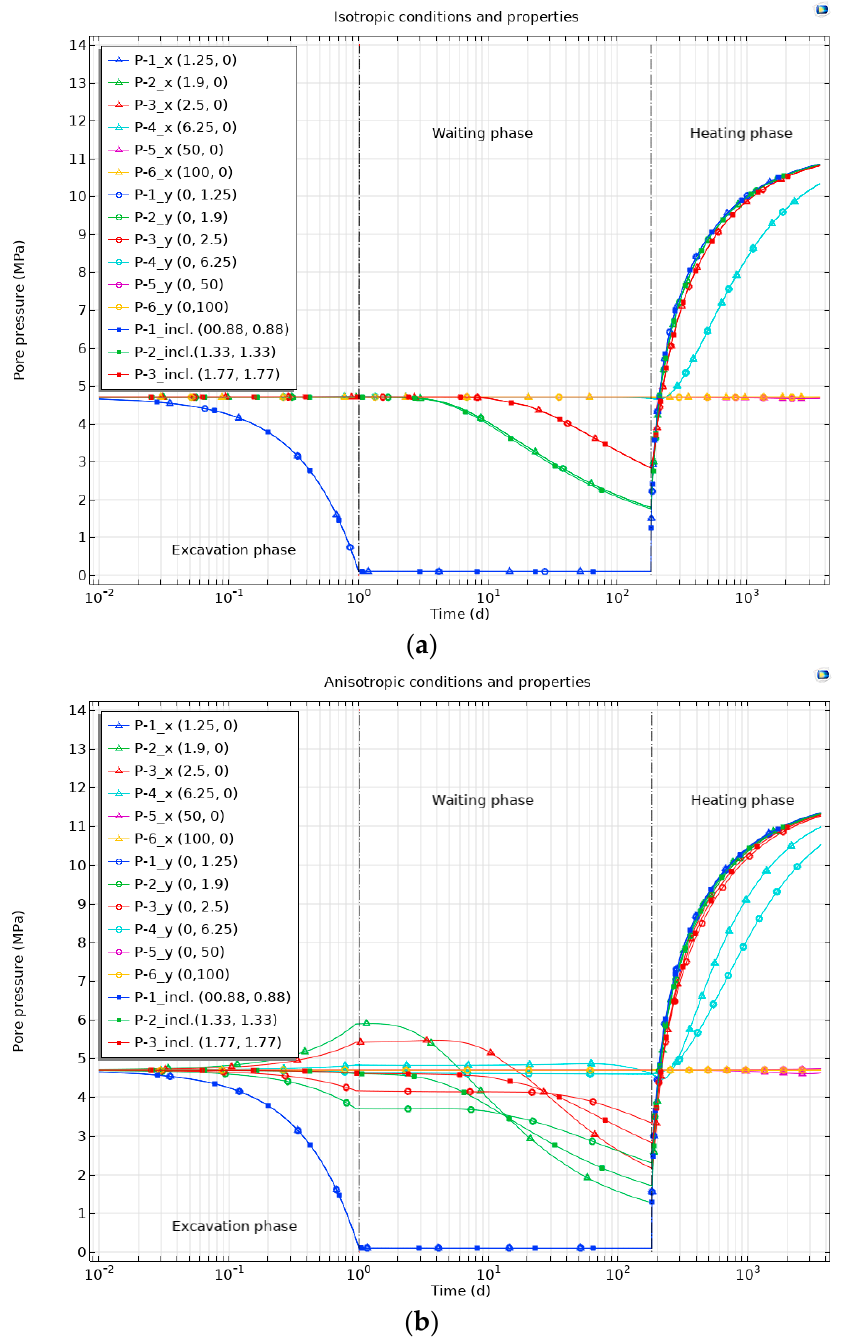
Figure 13. UDC variant: evolution of pore pressure at selected points:( a ) isotropic stress conditions and isotropic properties, ( b ) anisotropic stress conditions and anisotropic properties.